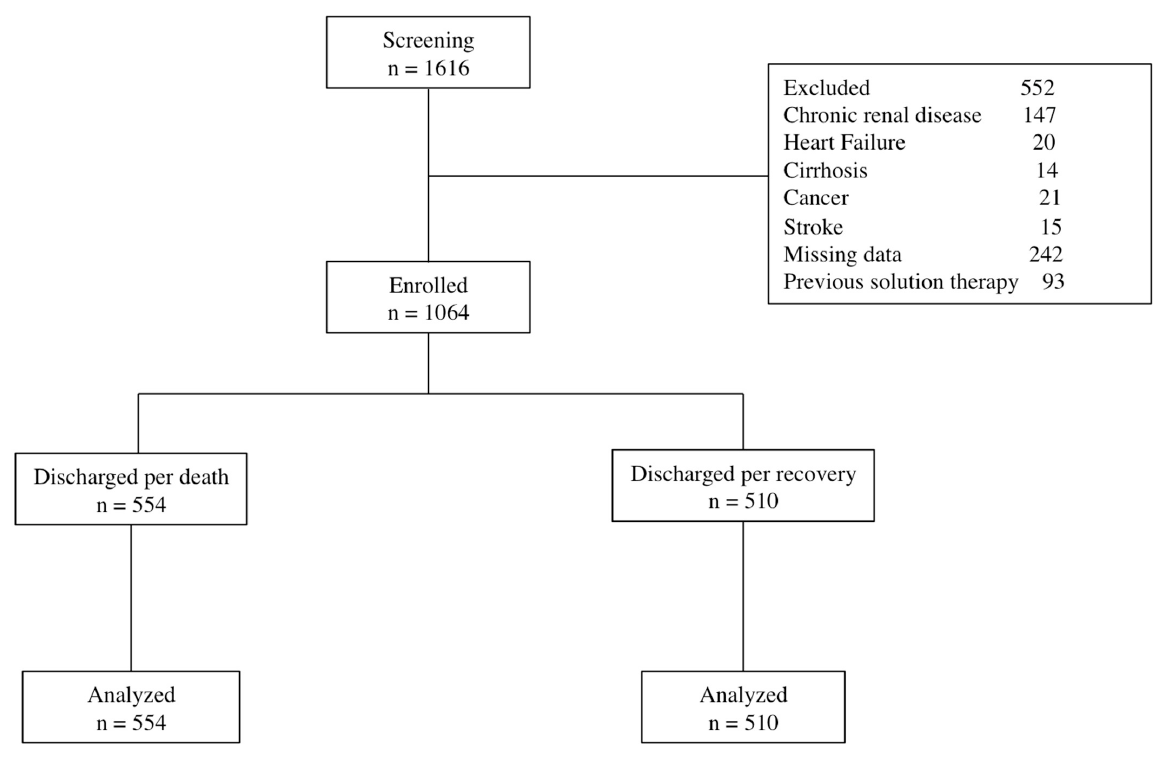
Figure 1. Flow chart.